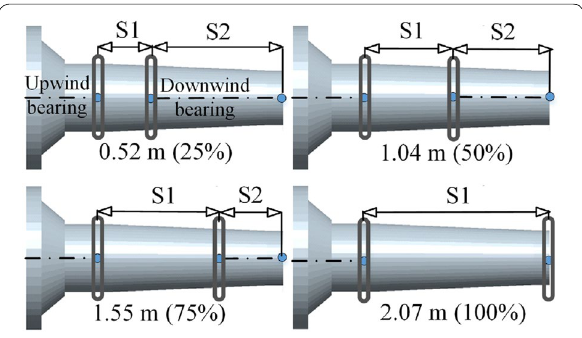
Figure 10 Different distance (S1) between two main